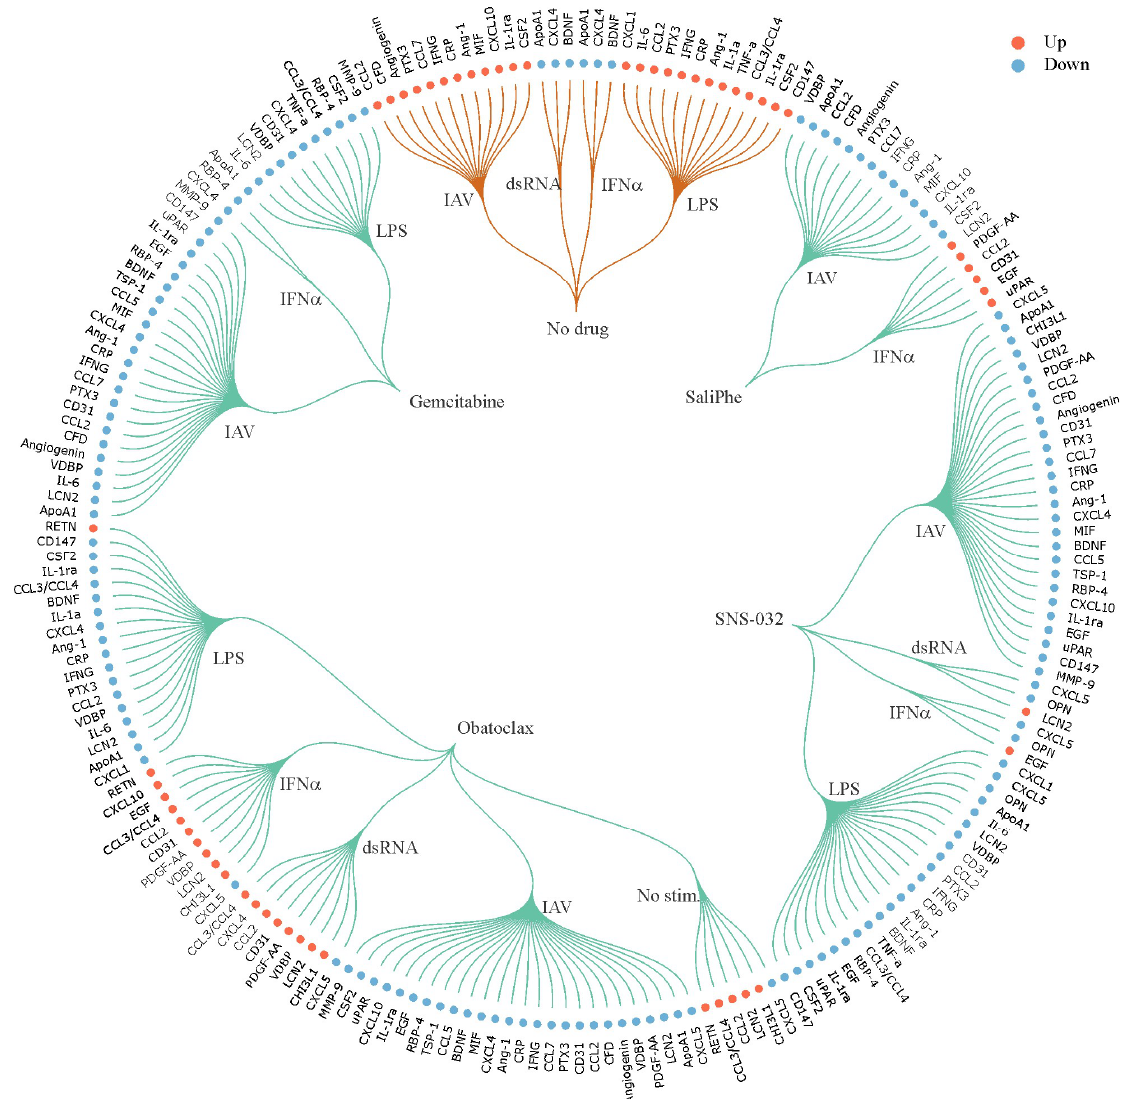
Figure 4. SaliPhe, SNS-032, obatoclax and gemcitabine differentially affect levels of cytokines and growth factors in the culture media of human PBMC-derived macrophages. PBMC-derived macrophages were treated with 3 μM SaliPhe, 0.1 μM SNS-032, 2 μM obatoclax, 1 μM gemcitabine or remained non-treated and infected with IAV (moi 1), or stimulated with 1 μg/mL dsRNA, 1 μg/mL LPS, 1 U/mL IFN-α, or remained non-stimulated. After 24 h, cell culture media were collected and 105 secreted proteins were subjected to analysis with human XL cytokine array kit. Soluble proteins, which relative levels were up- or down-regulated in response to stimuli in the media of non-treated cells, are indicated with orange curves. Soluble proteins, which relative levels were up- or down-regulated in response to stimuli in the media of drug-treated cells, are indicated with green curves.